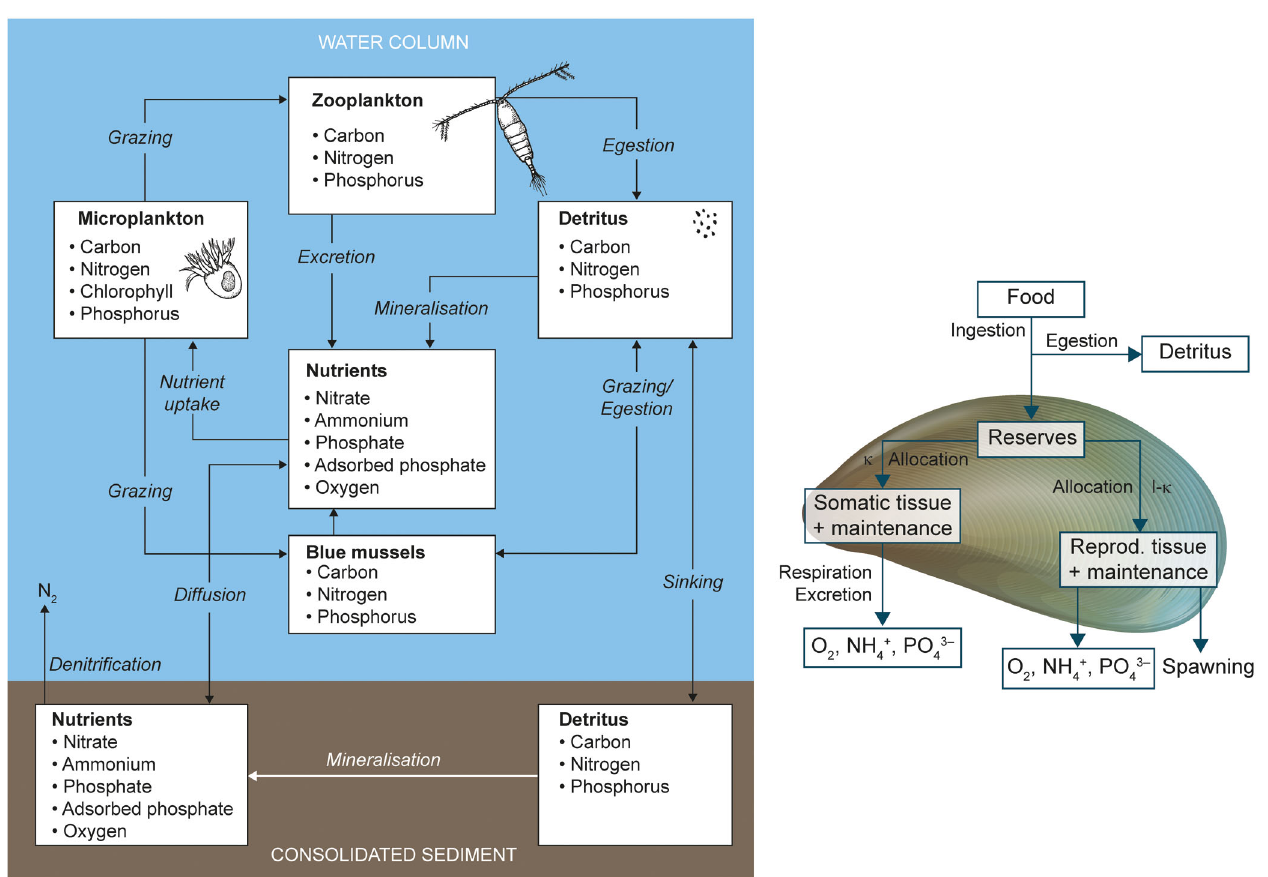
Fig. 2. Conceptual diagram of the coupled ecological DANECO model (left) and dynamic energy budget (DEB) model (right) for blue mussels used to assess and predict environmental effects of mitigation cultures. For both models, boxes represent state variables, whereas arrows represent processes. The feedback processes between DANECO and the DEB model are mussel in- gestion of food (microplankton and detritus carbon, nitrogen and phosphorus), nutrient excretion, respiration and egestion of fecal pellets into the DANECO detritus